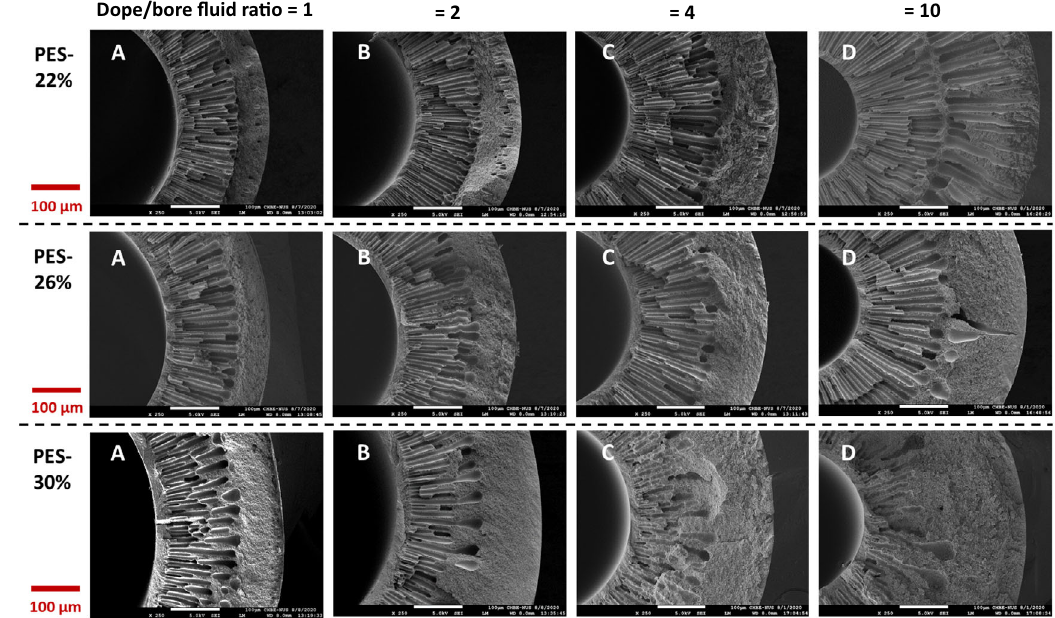
Fig. 2 A, B, C, D represent the simpli fi ed code names of PES hollow fi ber membranes with speci fi c ratio of dope to bore fl uid fl ow rate as shown on top of the fi gure, and in Tables 1 and 2. FESEM morphologies of selected cross-sections of the as-spun PES hollow fi ber membrane substrates.